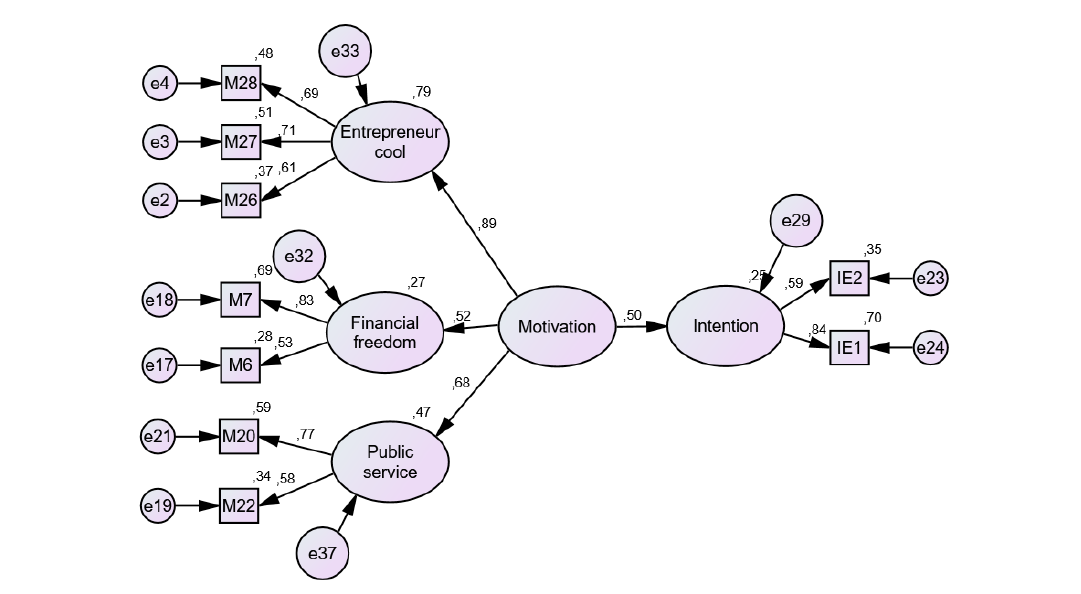
Figure 2. The structural model of the second model